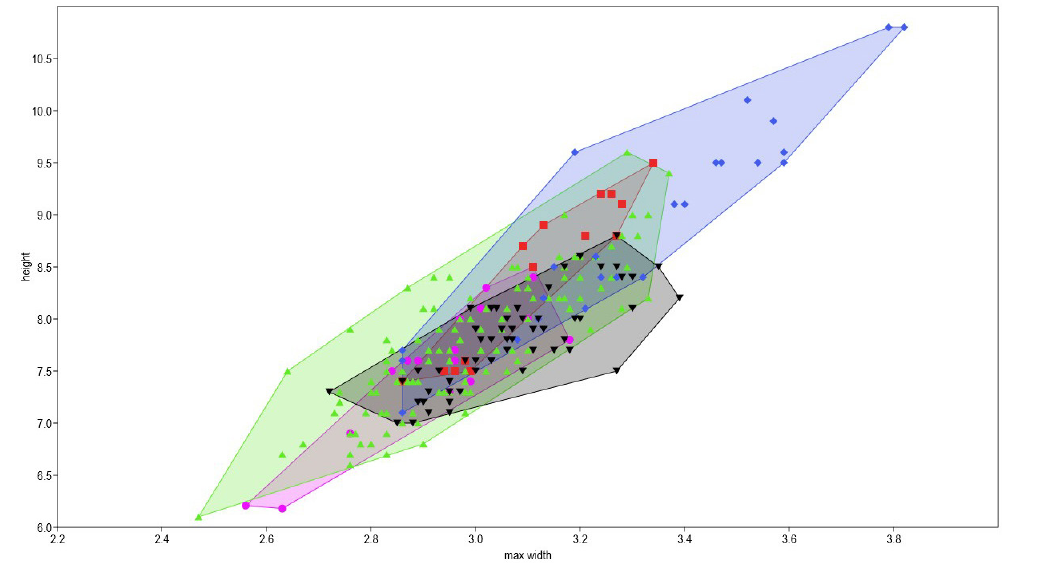
Fig. 10. Width of the 1 st whorl vs height (bottom) of the species in Clessiniella Zallot et al ., 2015. Violet dots = Cochlostoma ( Clessiniella ) anomphale Boeckel, 1939; red squares = Co. ( Cl. ) stelucarum sp. nov.; green triangles = Co. (Cl.) tergestinum (Westerlund, 1878); blue diamonds = Co. ( Cl. ) villae (Strobel, 1851); black triangles = Co. ( Cl. ) waldemari (A.J. Wagner, 1897). Analysis performed with the software ‘Past’